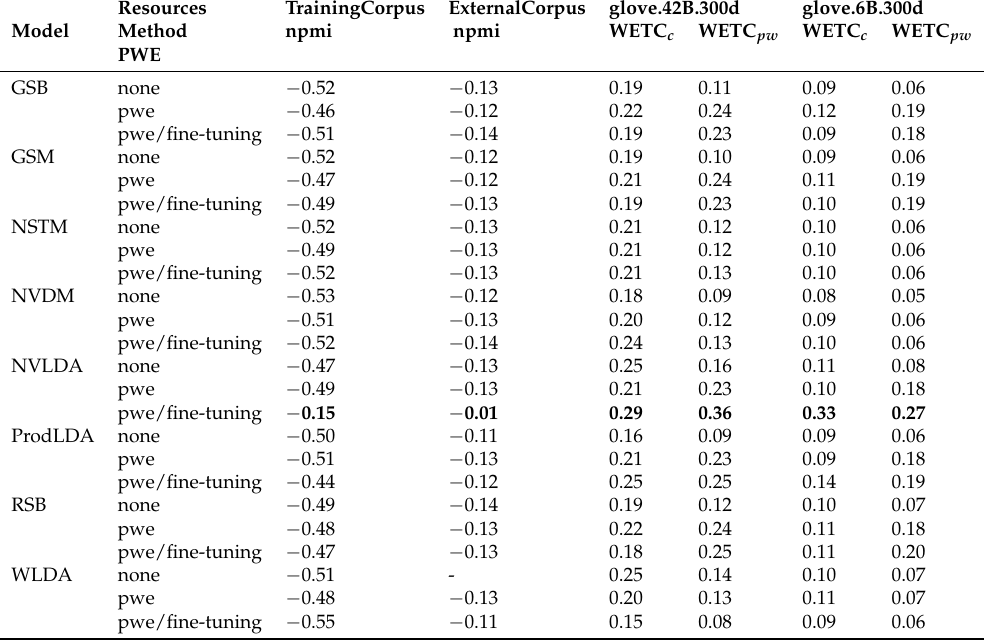
Table 5. Topic Coherence on